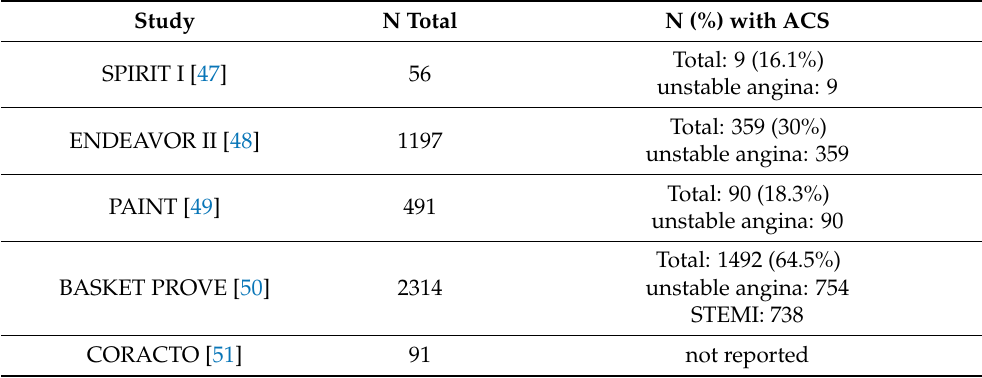
Table 4. Outcome comparison of this meta-analysis with Piccolo et al. 2022 IPDM in